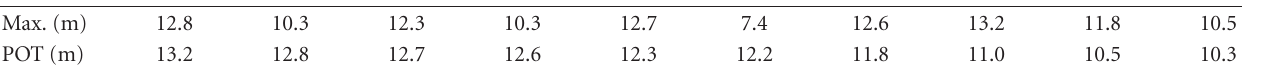
Table 2: Sampling result by di ff erent methods.